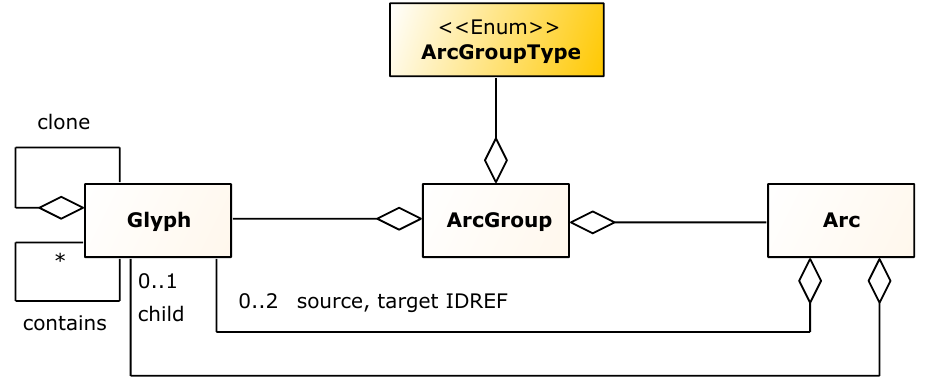
Figure 24: Visual representation of an Arc of class consumption (left) and an Arc of class production (right).